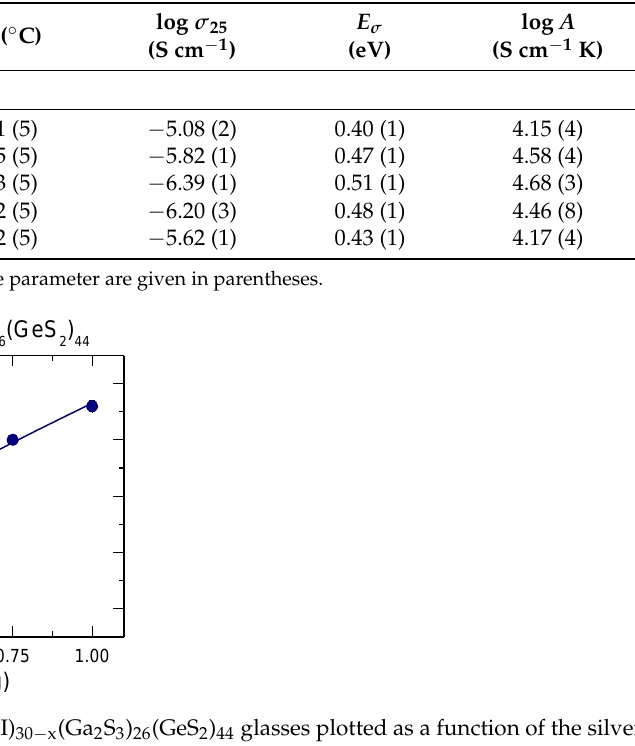
Table 1. Macroscopic properties of the (AgI) x (NaI) 30 − x (Ga 2 S 3 ) 26 (GeS 2 ) 44 glasses: density, d , glass transition temperature, T g , the room-temperature conductivity σ 25 , the activation energy E σ , and the pre-exponential factor A 1 .